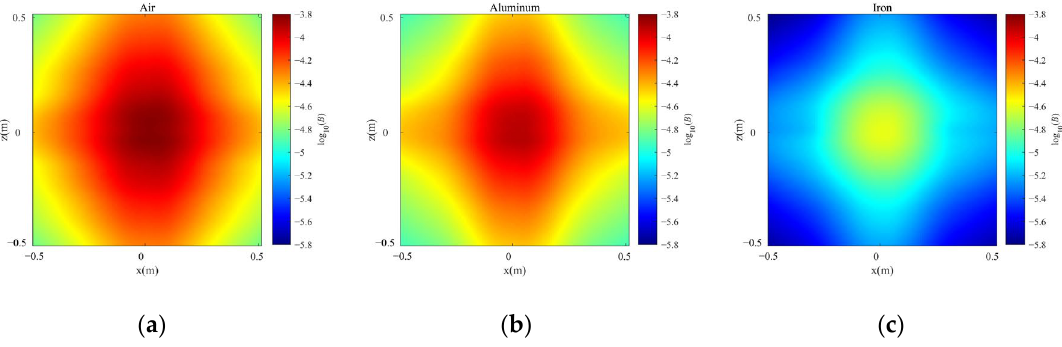
Figure 9. The distributions of magnetic flux density: ( a ) air; ( b ) aluminum; ( c ) iron.